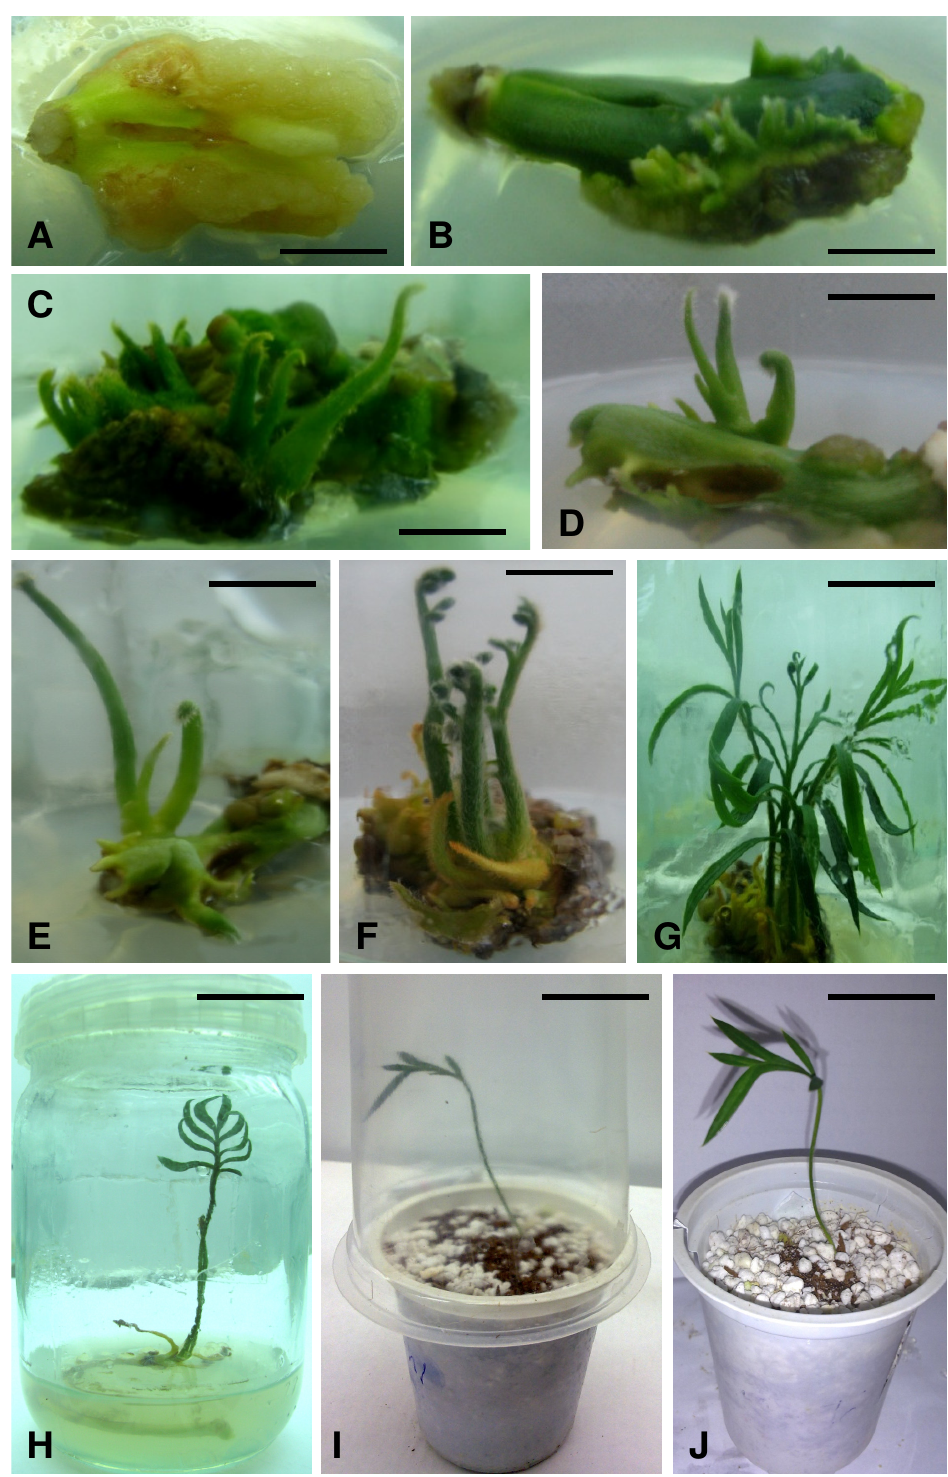
Fig. 1. Micropropagation of Cycas revoluta Thunb. (A) Callus induction from mature zygotic embryo (ZE) 35 days after the beginning of culture in MS basal medium in the presence of 0.5 mg l -1 of 2,4-D, Kin, BA × 2,4-D, BA×Kin and Kin × 2,4-D combinations (see Table 1). (B) Indirect adventitious shoot bud forming from the callus on a mature ZE 21 days after callus formation on MS medium supplemented with PGRs listed in (A). (C) Indirect adventitious shoots in response to 0.5 mg l -1 BA forming at 60 days after callus formation on medium described in (A). (D, E) Direct adventitious shoot formation from mature ZE 45 and 90 days (D and E, respectively) after culture on MS medium supplemented with 0.5 mg l -1 of BA. (F, G) Elongated shoots (pinnate leaves) originating from callus 120 and 185 days (F and G, respectively) after callus formation on MS medium supplemented with PGRs listed in (A). (H) Rooted plantlet in MS + 0.1 mg l -1 NAA. (I) Plantlet during hardening in perlite substrate. (J) Acclimatized plantlet. Scale bars: 10